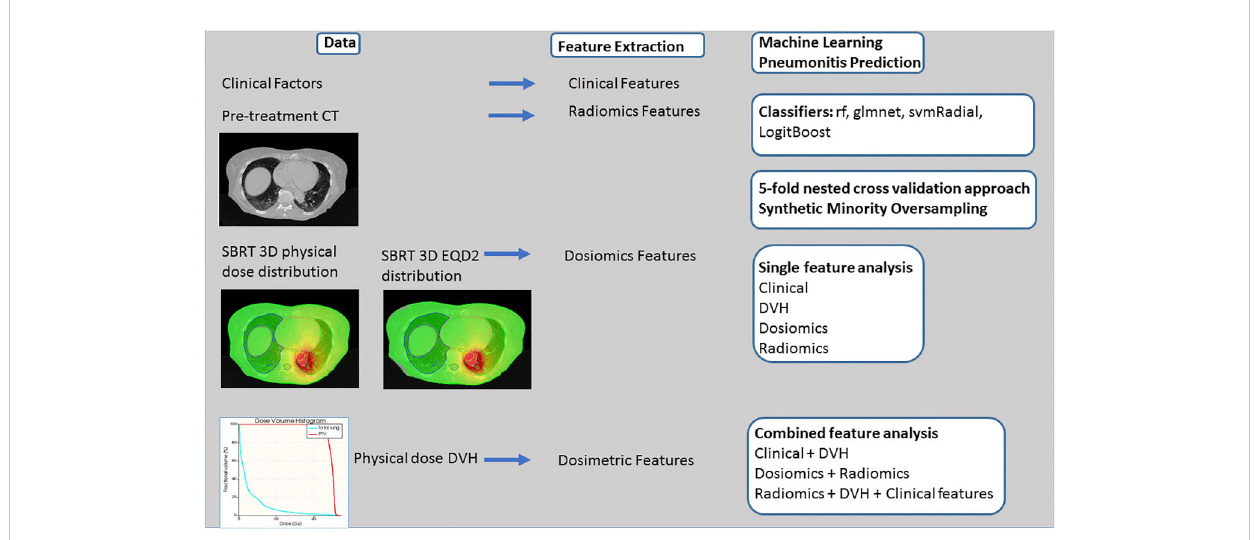
FIGURE 2 Process fl ow. Clinical, Computed Tomography (CT) and 3D dose volume and dose volume histogram (DVH) data is used for feature extraction. PTP prediction is performed testing different classi fi ers such as random forest (rf), logistic elastic net regression (glmnet), support vector machine (svmRadial), and logitBoost and 5-fold nested cross validation approach and Synthetic Minority Oversampling. Four single models and fi ve combined models are analyzed.